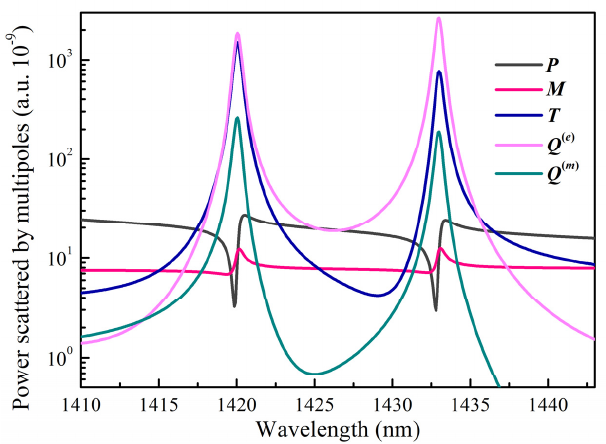
Figure 5. Far − field scattering contributions of electric dipole P , magnetic dipole M , toroidal dipole T , electric quadrupole   e Q , and magnetic quadrupole   m Q .